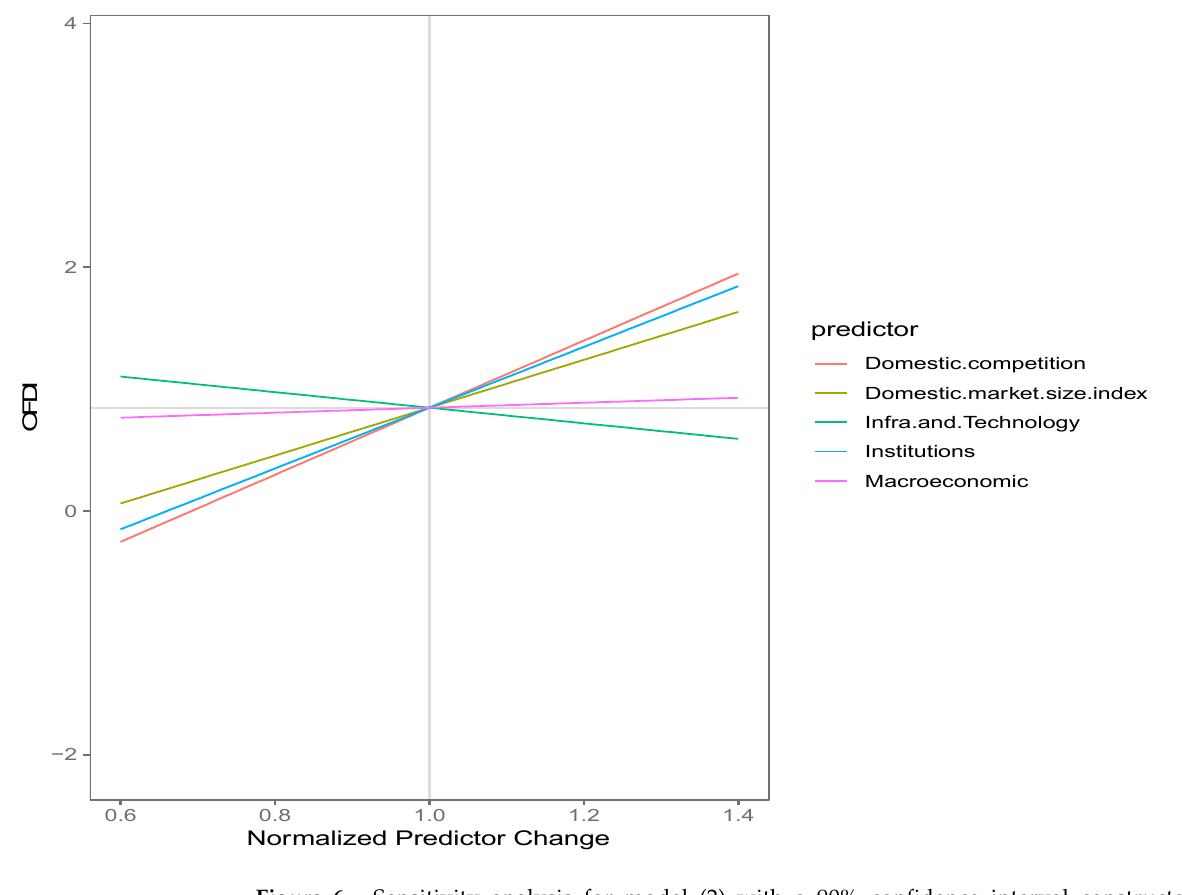
Figure 5. Sensitivity analysis for model (1) with a 90% confidence interval constructed for each pre- dictor.